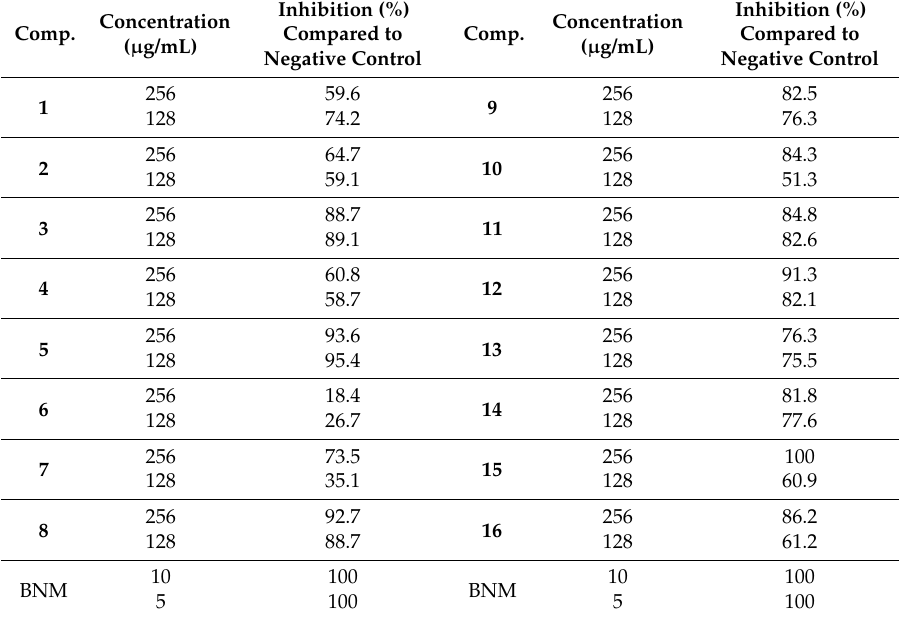
Table 4. Inhibition (%) of Bipolaris sorokiniana conidium germination by compounds 1 – 16 in comparison to negative control. Benomyl (BNM) was used as positive